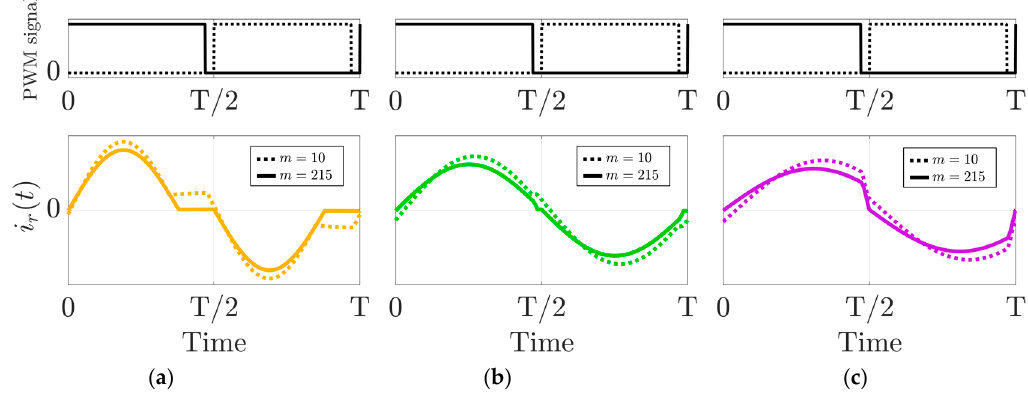
Figure 4. LLC converter modes: ( a ) below resonance; ( b ) at resonant; ( c ) above resonance.